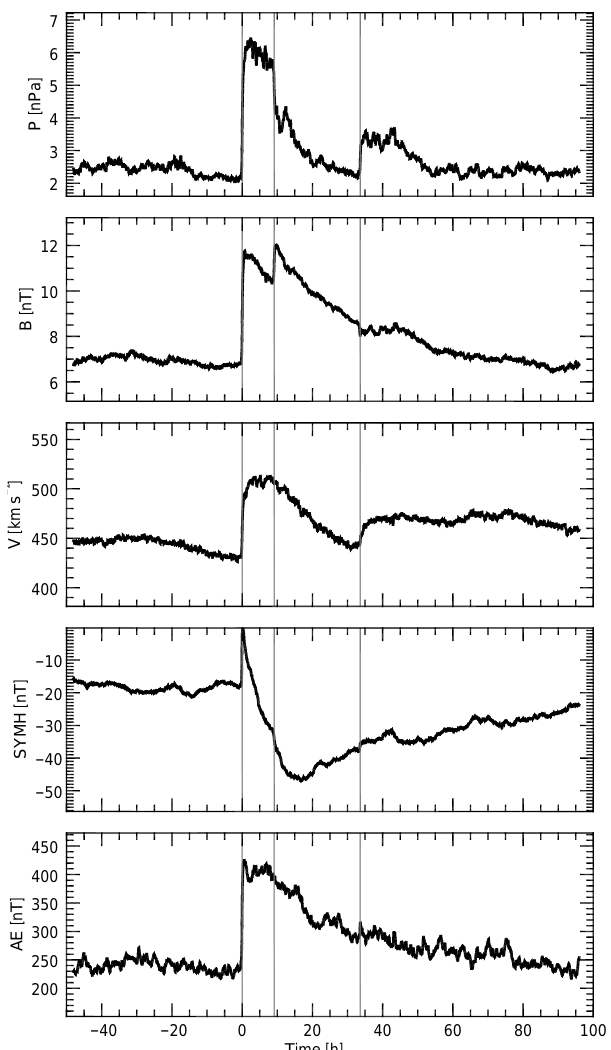
Figure 2. SEAs of three SW parameters ( B , P , V ) and two geo- magnetic indices (SYM-H and AE) for 306 ICMEs between 1996 and 2008. The three vertical lines are the epoch times indicating (re- spectively from left to right) the onset of the sheath, the onset of the ICME, and the end of the